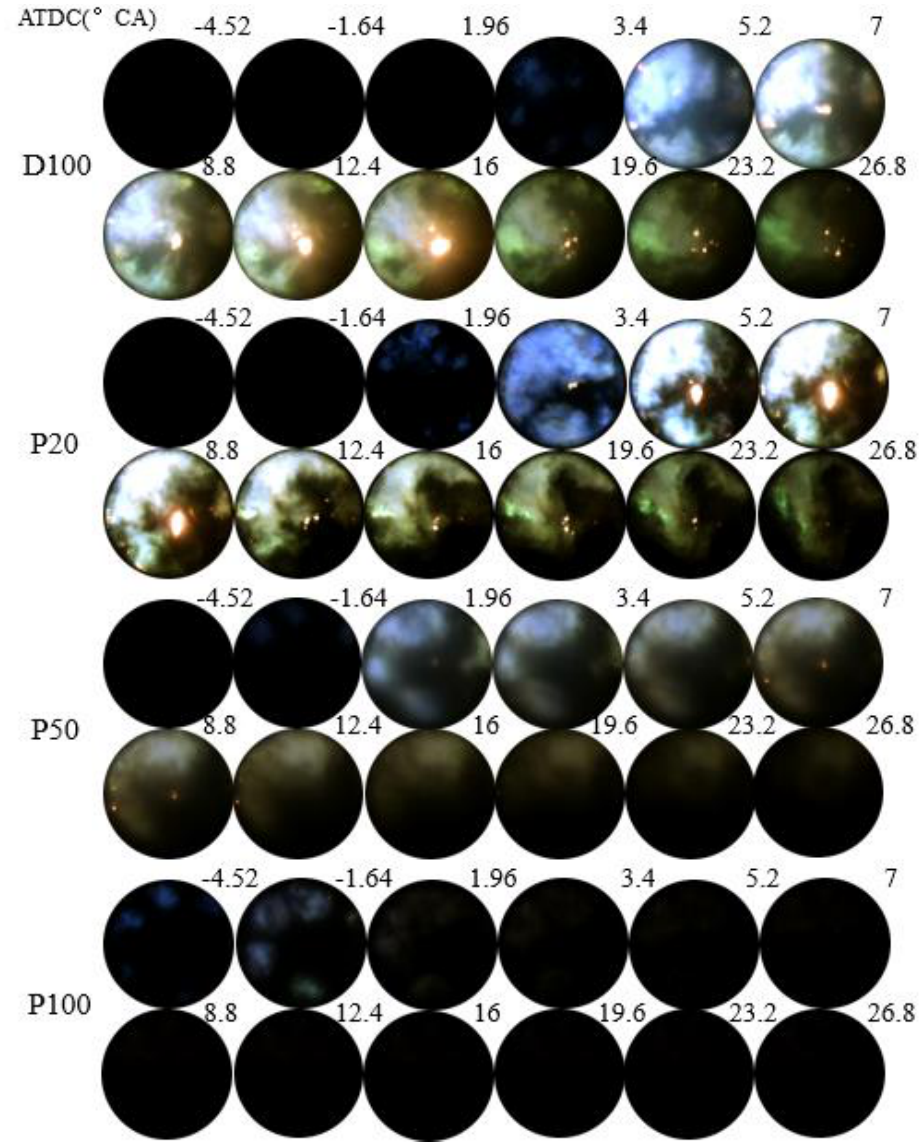
Figure 8. The combustion images (Injection pressure: 140 MPa; Injection timing: 12 °CA BTDC).